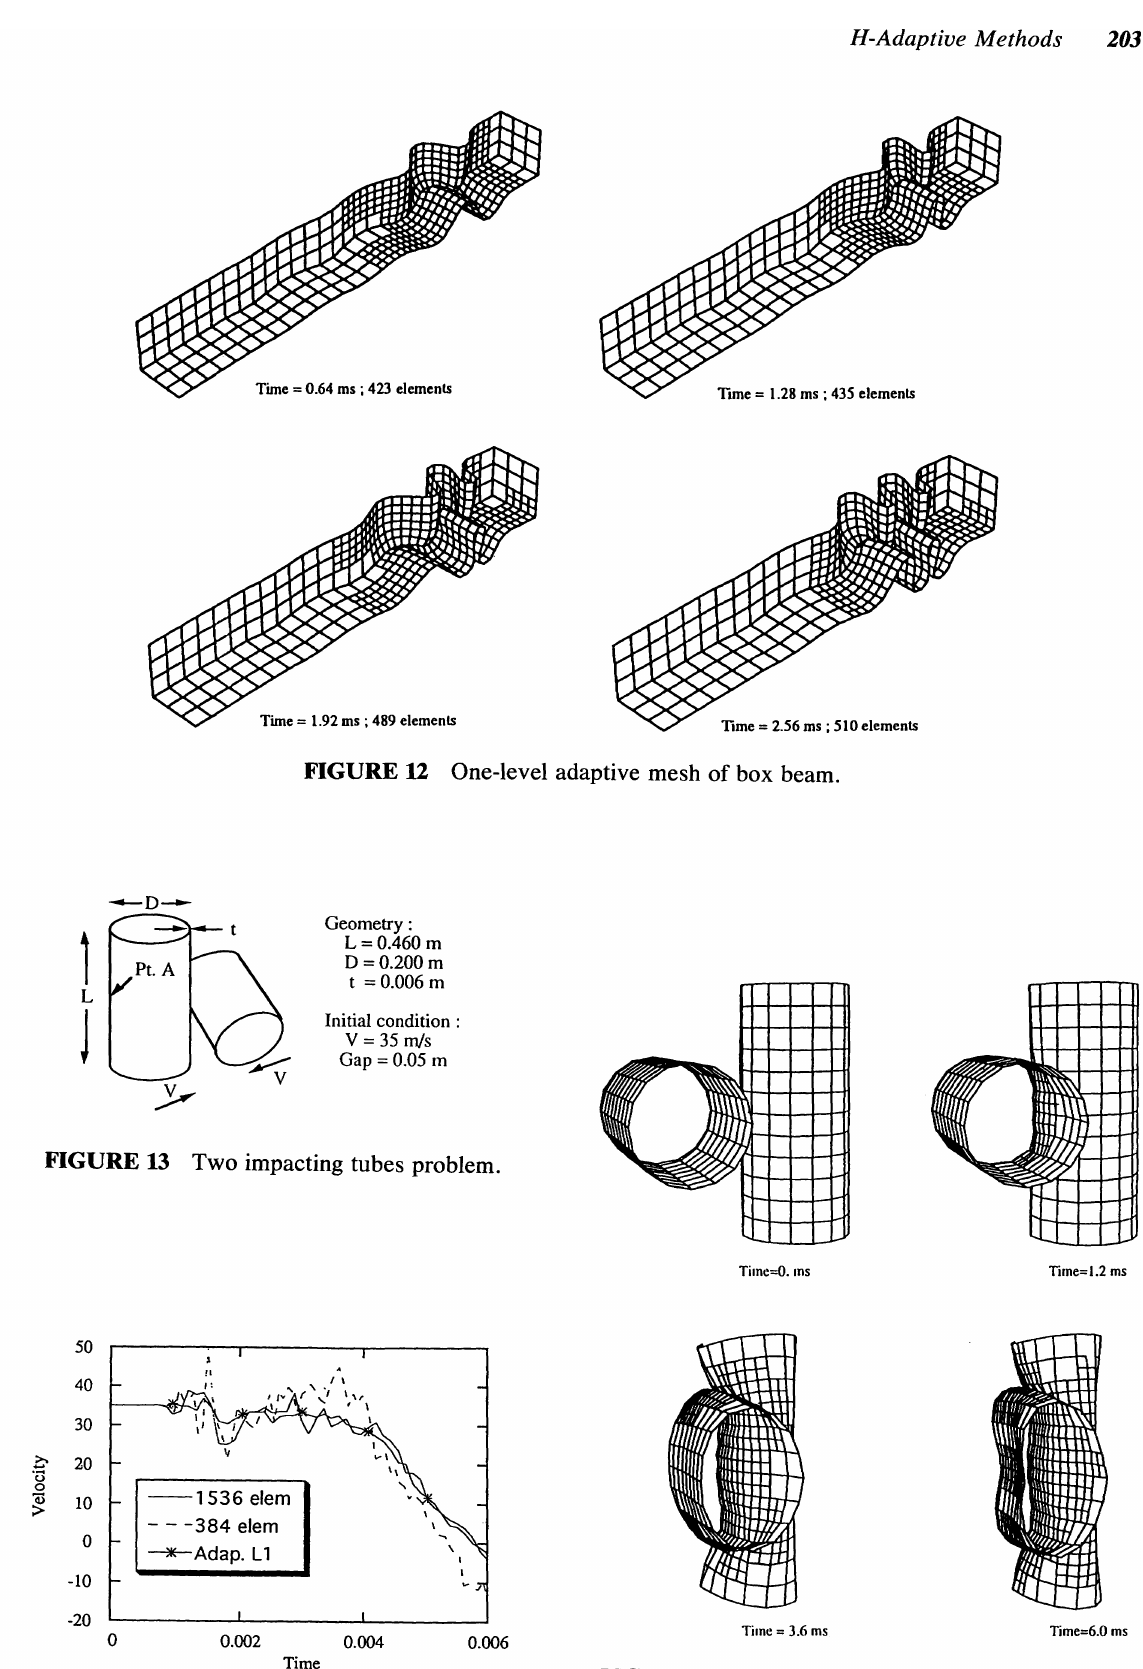
FIGURE 15 One-level adaptive mesh of impacting